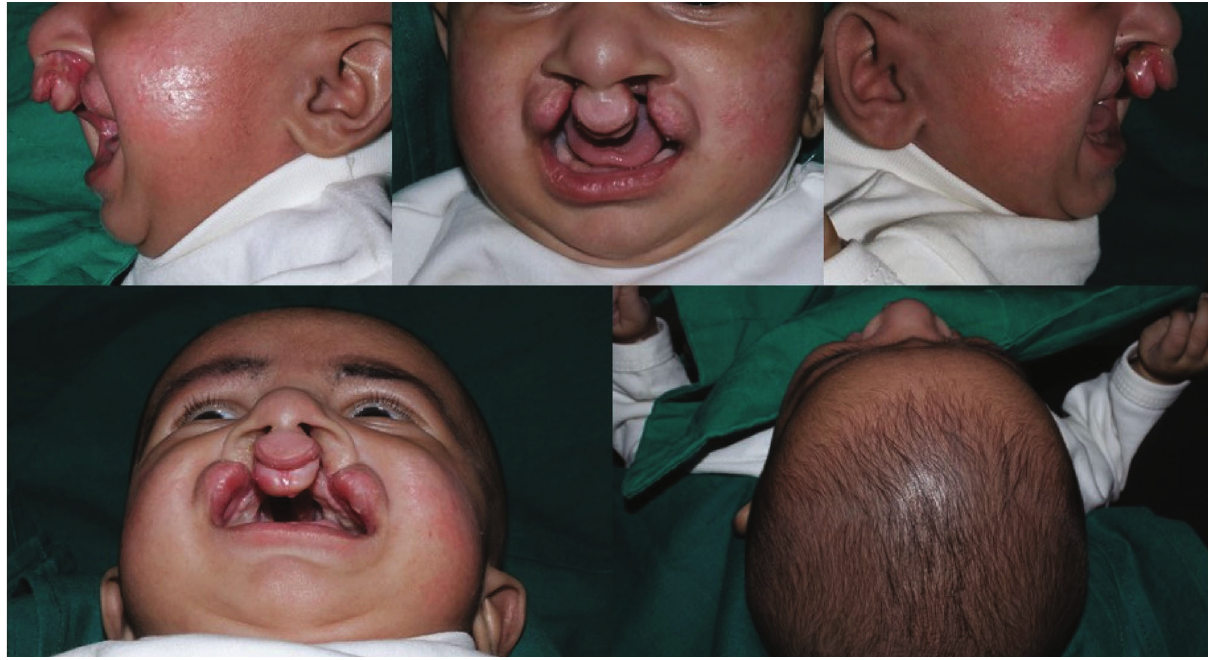
Figure 5: Post 3D Versascrew appliance: The treatment outcomes are listed herewith (Figure 5):